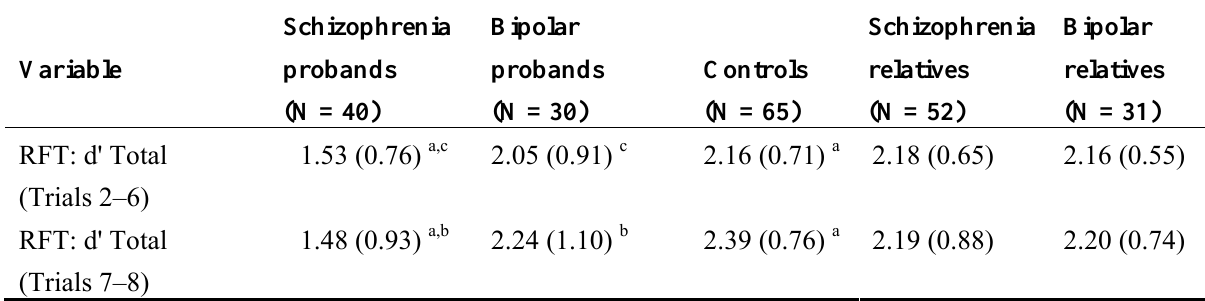
Table 3. Mean d´ scores (and standard deviation) for the Recurring Figures Test and